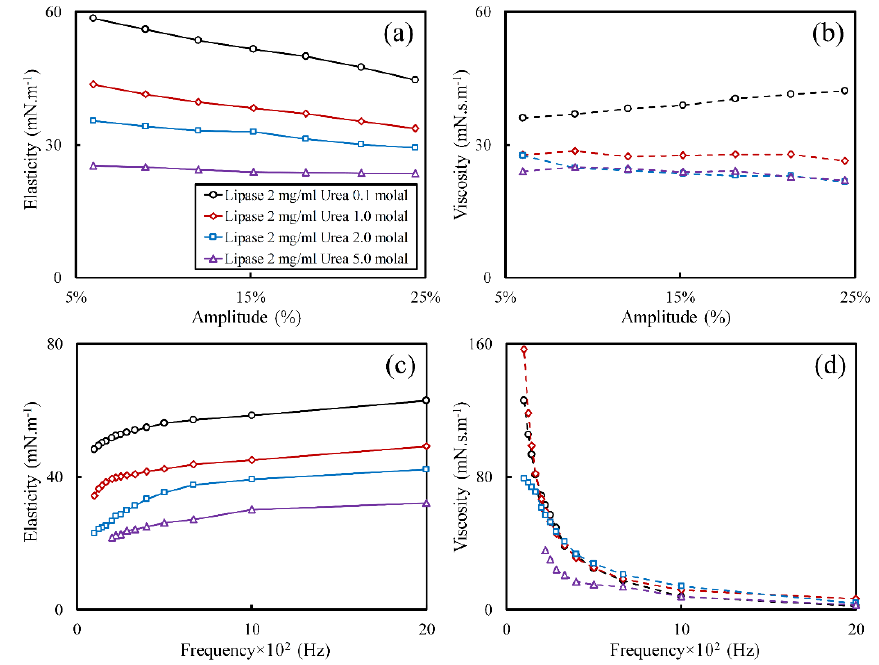
Figure 3. Effect of urea on the interfacial viscoelastic properties of the adsorbed layers from lipase 2.0 mg · mL − 1 solutions with urea concentrations of 0.1, 1.0, 2.0, and 5.0 molal: effect of amplitude ( a , b ) and frequency ( c , d ) of the imposed sinusoidal perturbations of the interfacial area on the elasticity and viscosity of the adsorbed layers; the solid and dashed lines are drawn as a guide for the